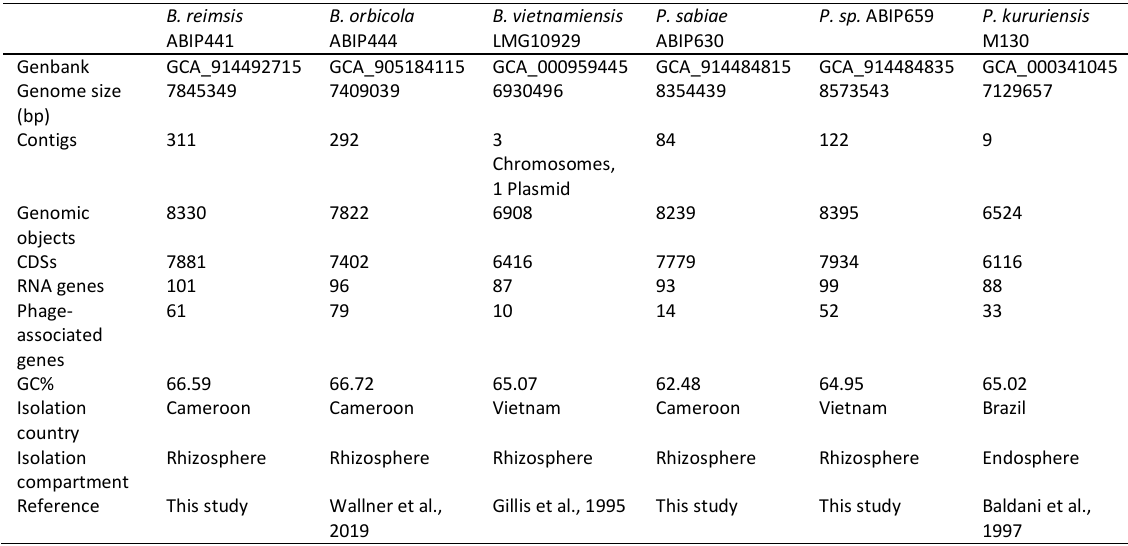
Table 1 - List of the six strains used in this study and their genomic characteristics.